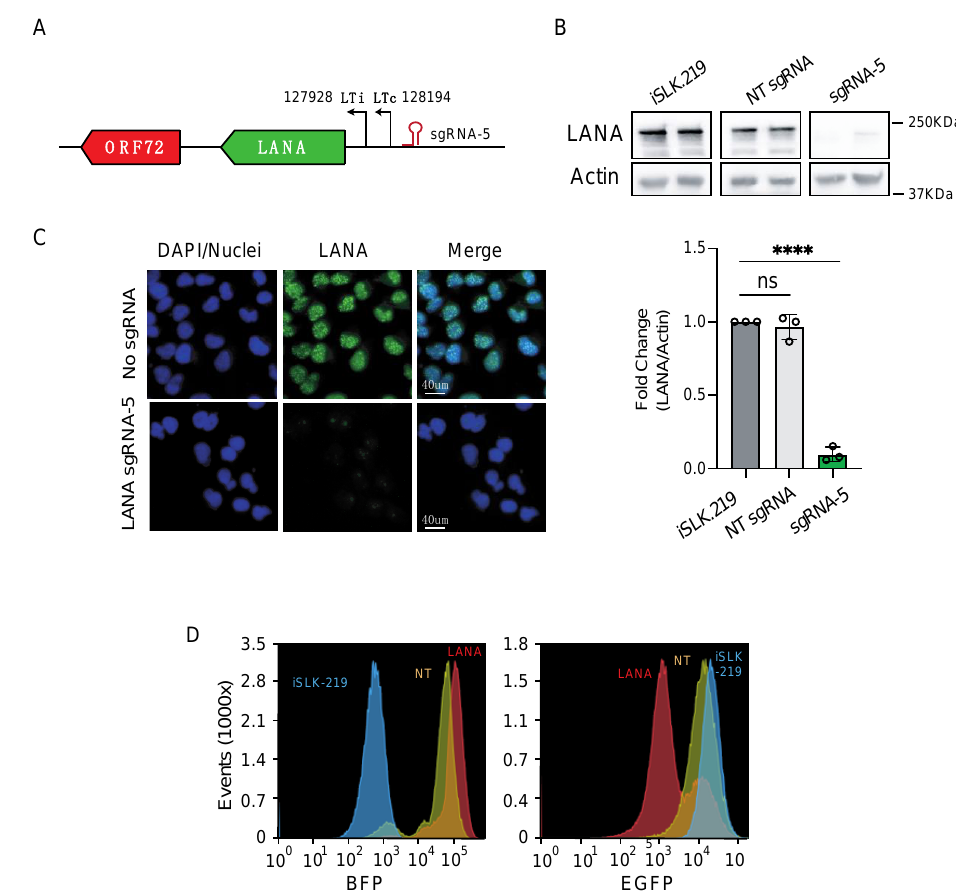
Figure 3. CRISPRi silencing of latent genes in iSLK-219 cells. ( A ) Region of the viral genome encoding LANA (ORF73) and position of the sgRNA. ( B ) Immunoblot analysis of LANA in iSLK-219 cells, and iSLK-219-dC9K cells transduced with a non-targeting (NT) sgRNA or a LANA specific sgRNA. Image representative of three biological replicates. Bars: quantification of the data. (one-way ANOVA, **** p < 0.0001). Error bars: standard deviation, ns, not significant. ( C ) Immunofluorescence analyses of LANA in methanol-fixed iSLK-219-dC9K cells transduced with a LANA specific sgRNA. Image representative of three biological replicates. ( D ) Flow cytometry analyses (MFI) of iSLK-219 (blue trace), or iSLK-219-dC9K cells transduced with a non-targeting (NT) sgRNA (yellow trace) or a LANA specific sgRNA (red trace). Note the downregulation of EGFP expression in cells where LANA has been silenced. Image representative of two biological replicates.